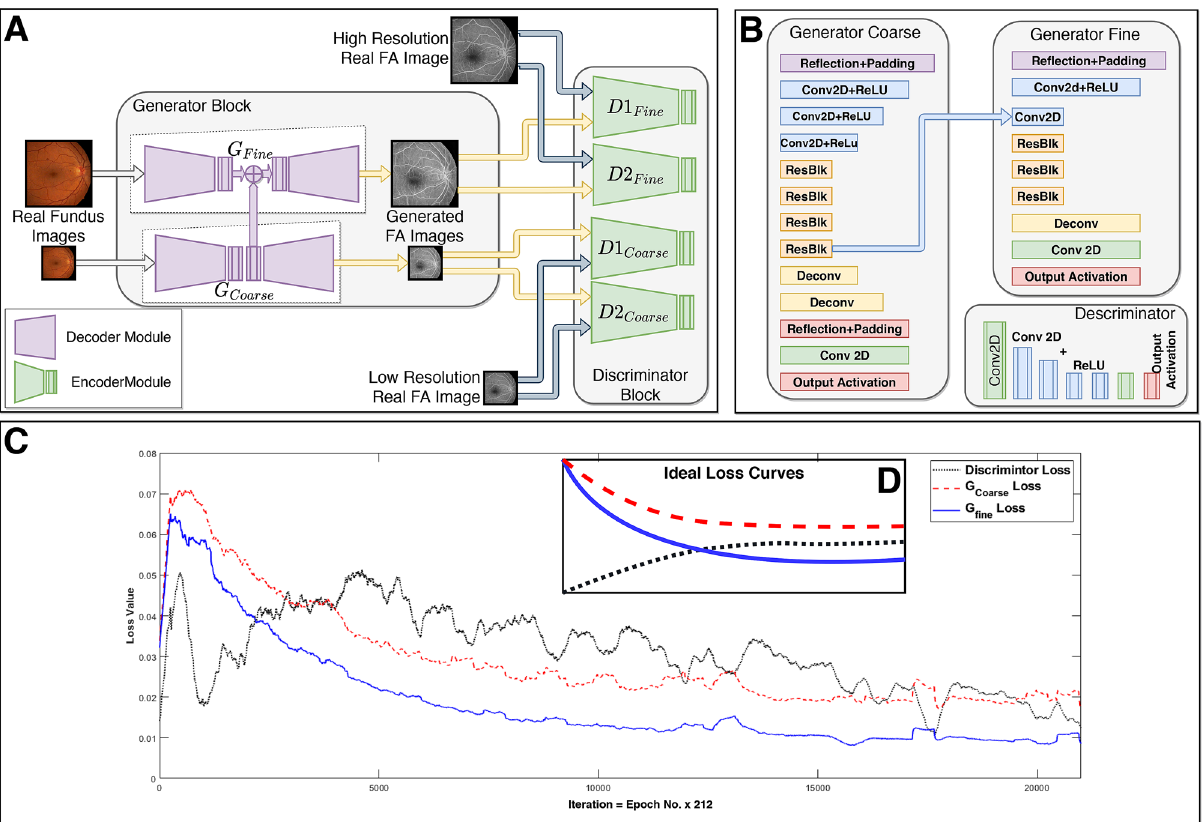
Figure 1. Generative Adversarial Network (GAN) models used for producing anatomically accurate FA images from fundus photographs ( A ). Details of the generator blocks and discriminator blocks of the proposed network ( B) . Generator and discriminator block loss values as a function of training iterations ( C ). Ideal loss curves ( D